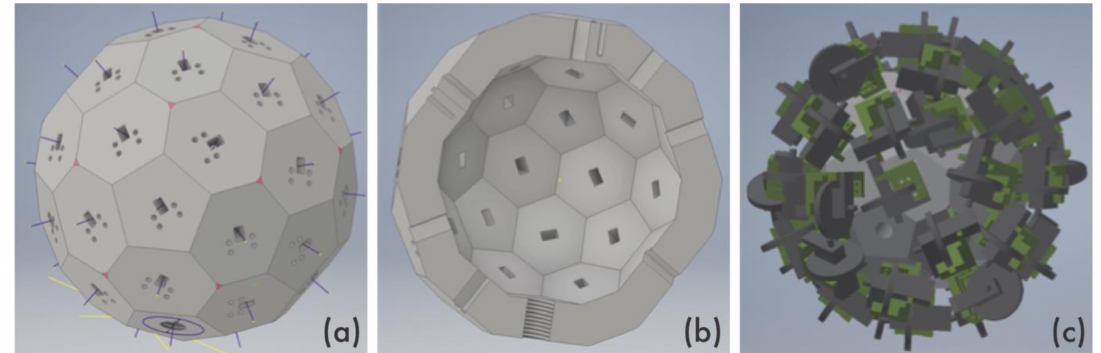
Figure 10. Design of a core that attaches the actuators directly on the surface; guide core ( a ), sectional view ( b ), and guide core with actuators ( c ).